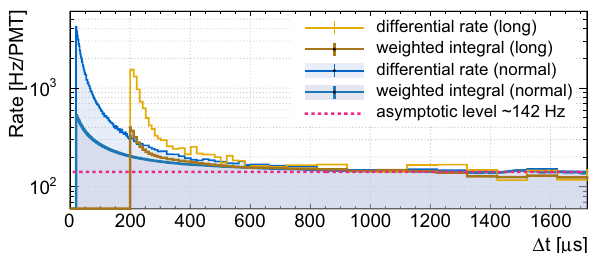
Fig. 3 The pre-event light level as a function of Δ t , for normal (16 µ s) and long (200 µ s) PMT trace data. Both the differential rate, and the average light level above the Δ t value (see text) are shown. In all cases, the curves approach a light level of approximately 142 Hz. The peaks at 20 µ s and 200 µ s are due to pile-up (see